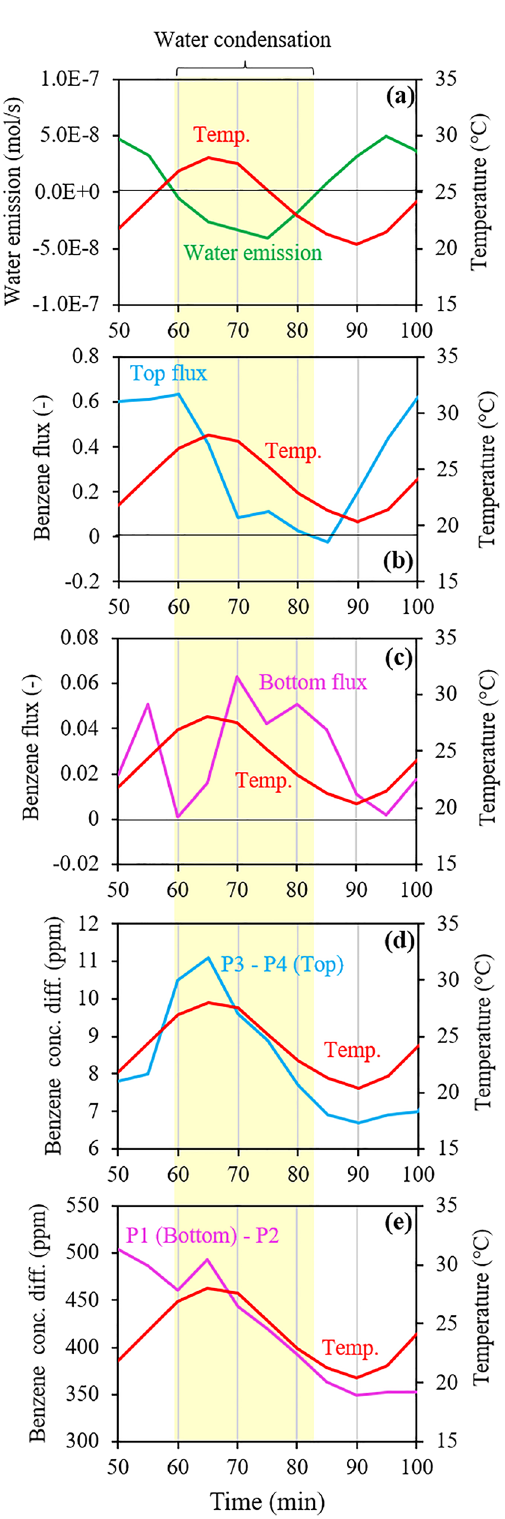
Figure 4. Changes in ( a ) water emissions; ( b ) top and ( c ) bottom benzene fluxes; and ( d and e ) upper and lower benzene concentration differences during 50–100 min in Run 2 under dynamic temperature (20 ‒ 30 °C). Note that the flux value at each time is represented by a ratio of the observed value at each time to the largest observed value during the entire experimental